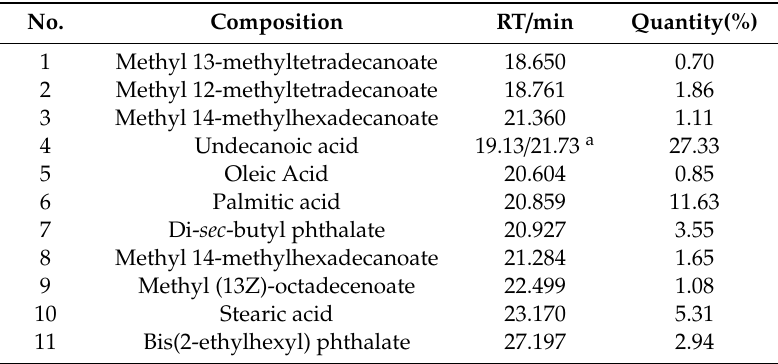
Table 2. The chemical composition of petroleum ether–ethyl acetate